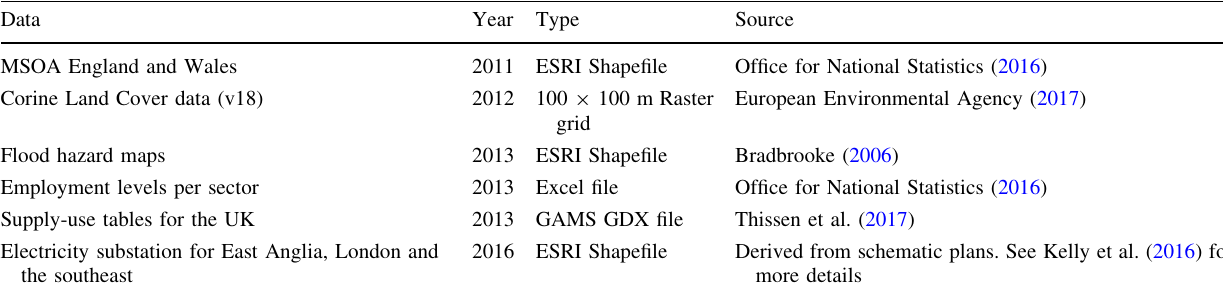
Table 1 Main datasets used in the United Kingdom electricity failures and flooding